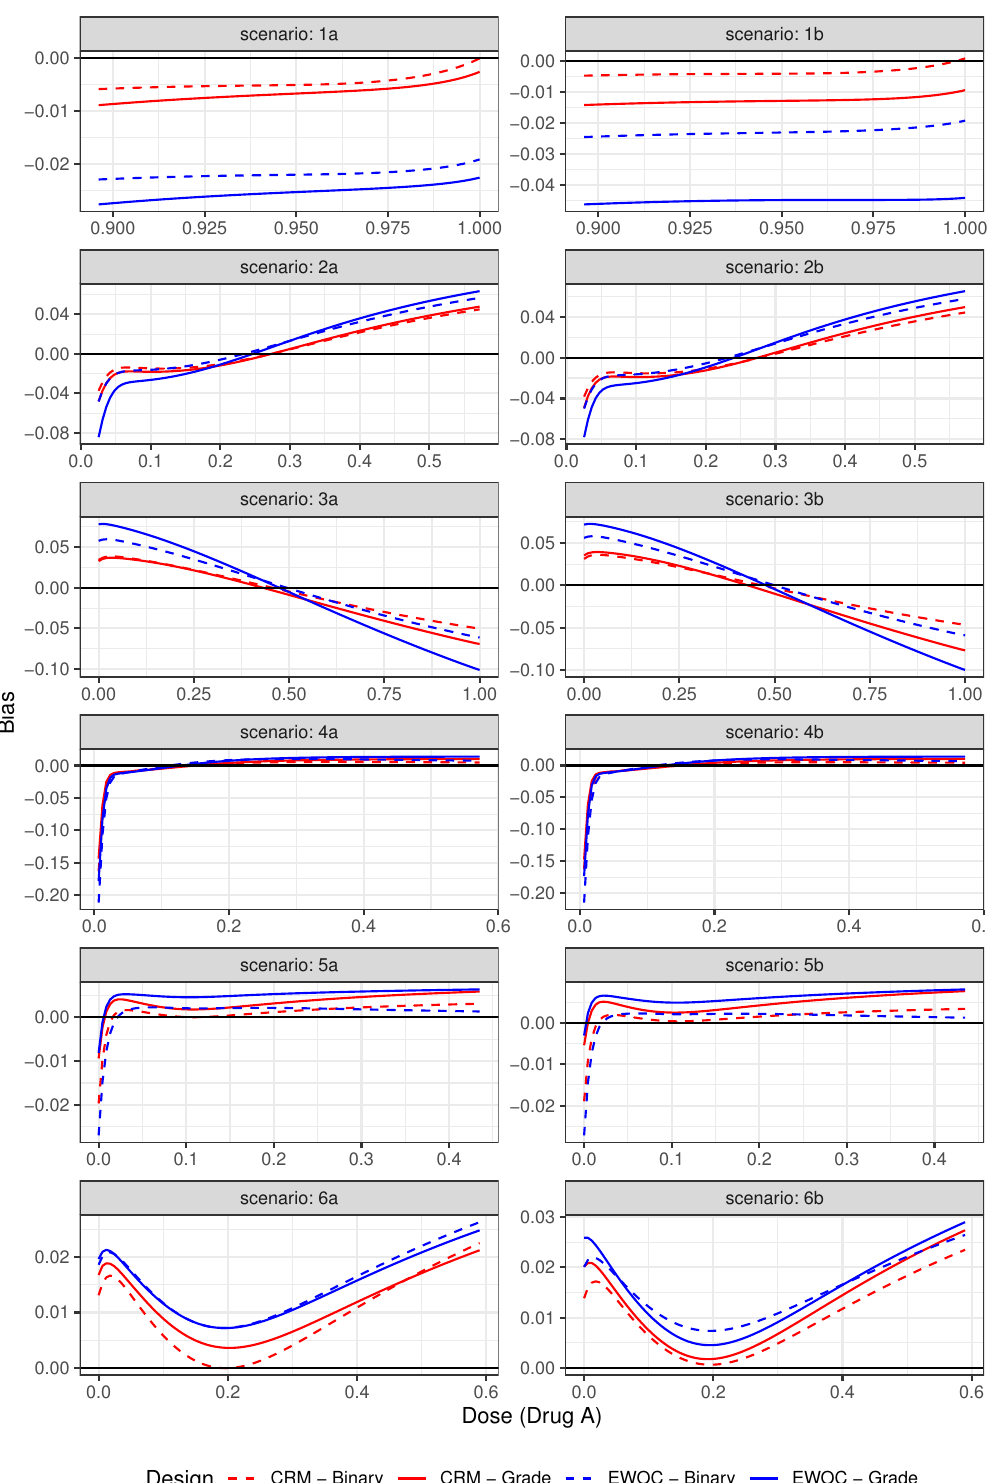
Figure 2. Pointwise average relative minimum distance from the true MTD curve to the estimated MTD curve under Scenarios